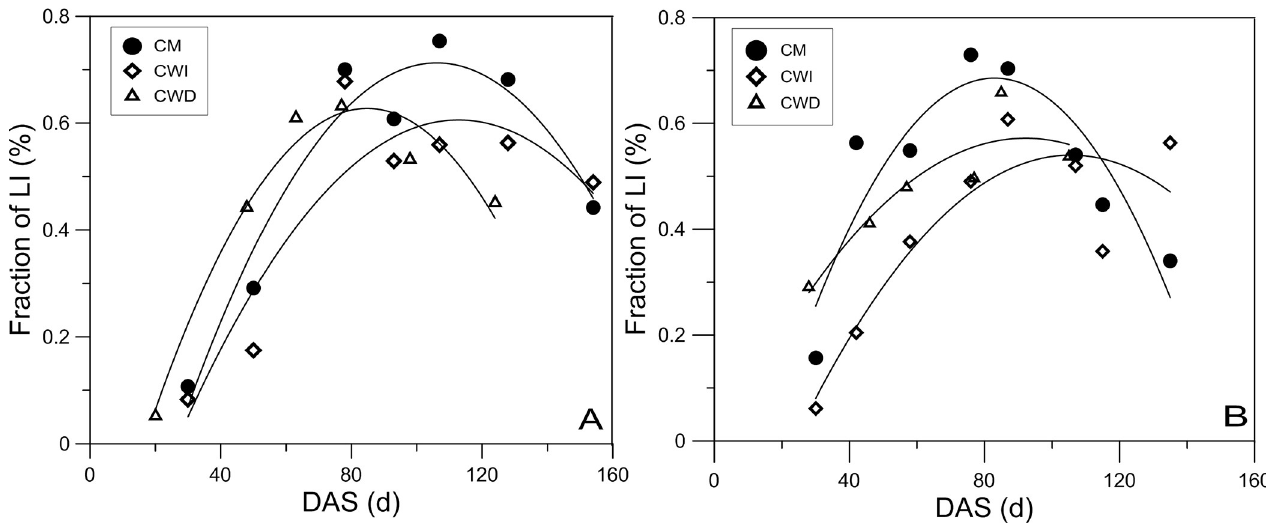
Fig 2. Fraction of light interception in the different planting patterns in 2016 (A) and 2017